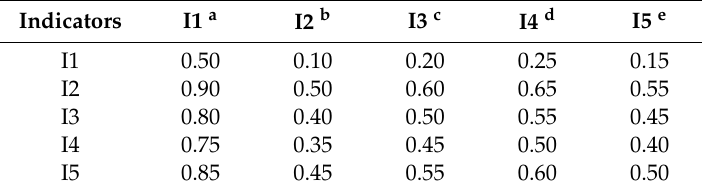
Table 2. Constructed FCM of five indicators by Wang [23].